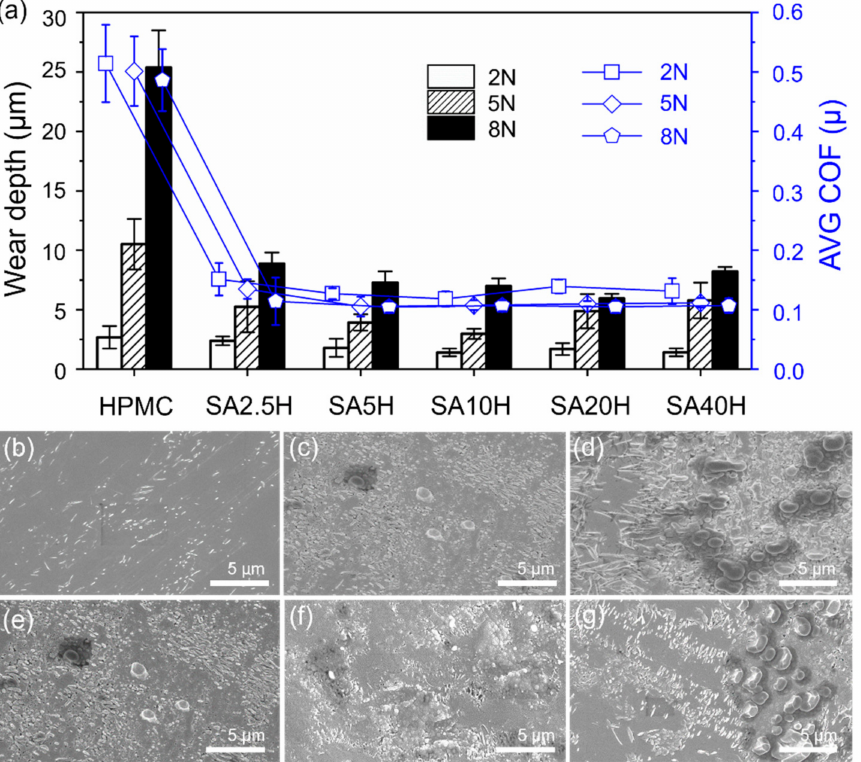
Figure 4. ( a ) Short-range wear depth and average coefficient of friction. Interface observation of ( b ) SA5H, ( c ) SA20H, and ( d ) SA40H. The SA20H surface under ( e ) 2 N, ( f ) 5 N, and ( g ) 8 N.